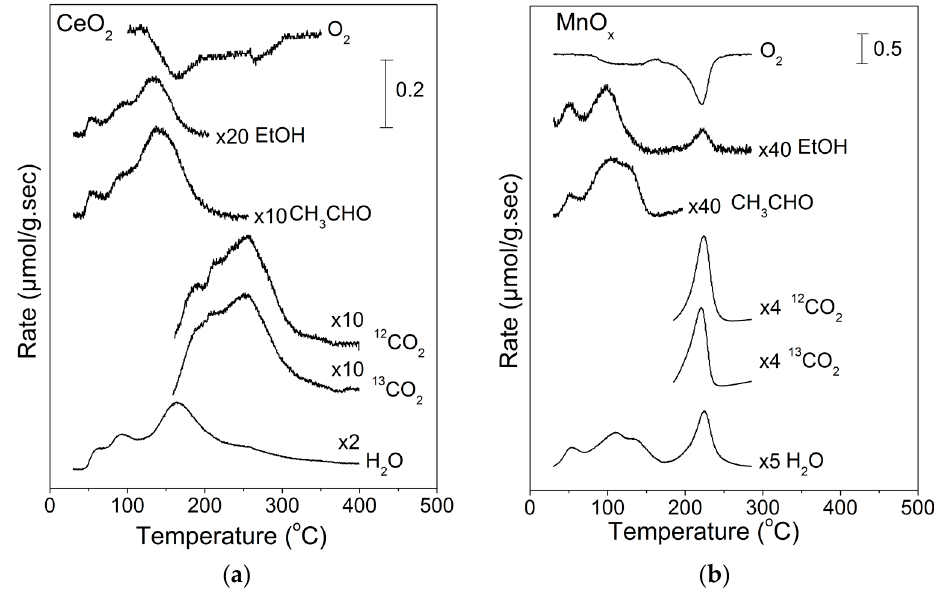
Figure 3. ( a ) TPO profiles following 12 CH 313 CH 2 OH adsorption on pure CeO 2 , ( b ) TPO profiles following 12 CH 313 CH 2 OH adsorption on pure MnO x .